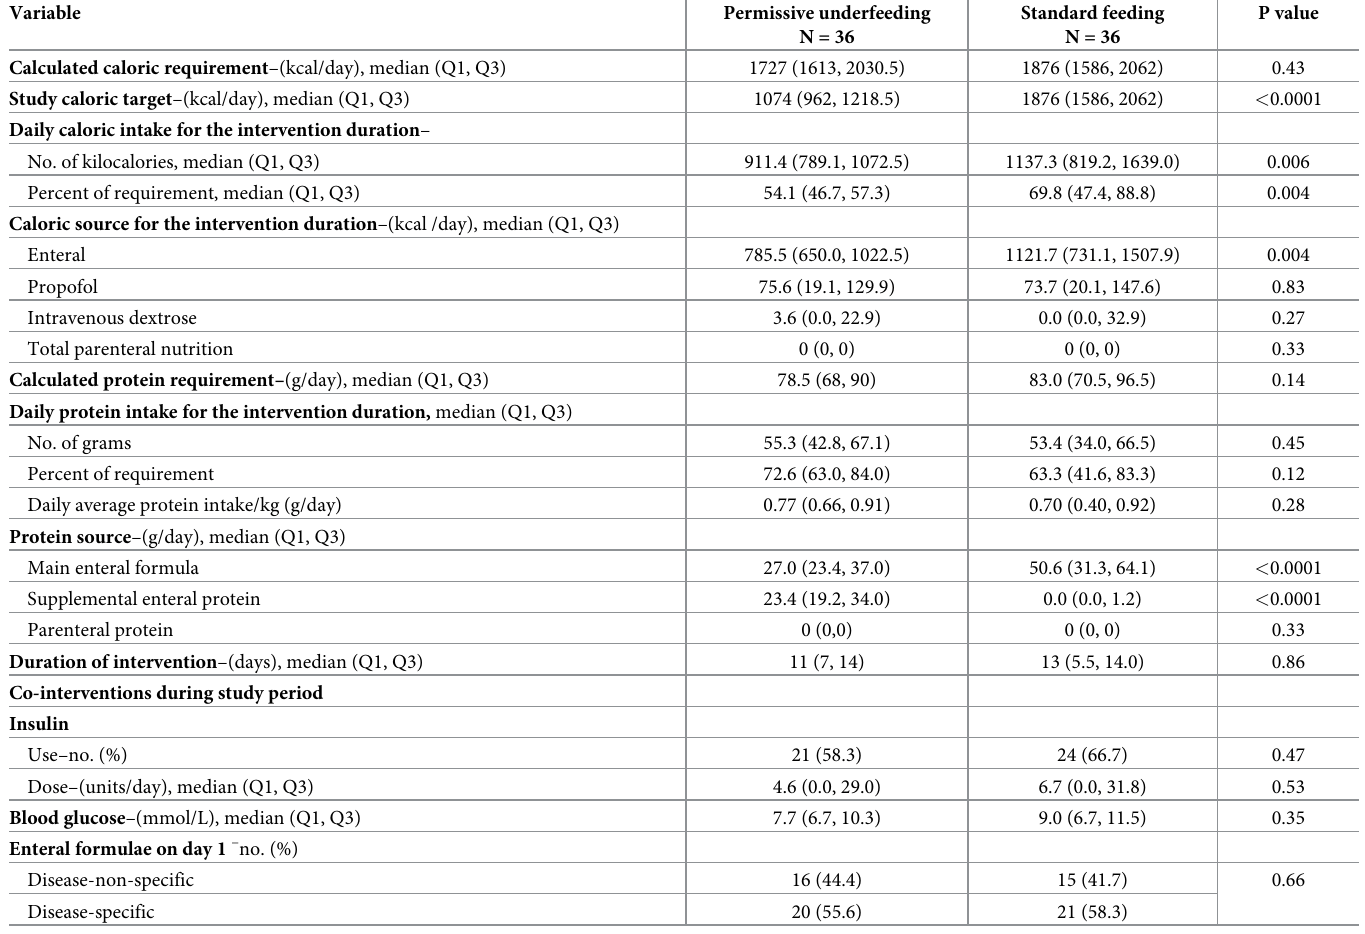
Table 2. Nutritional and metabolic data in patients in the permissive underfeeding and standard